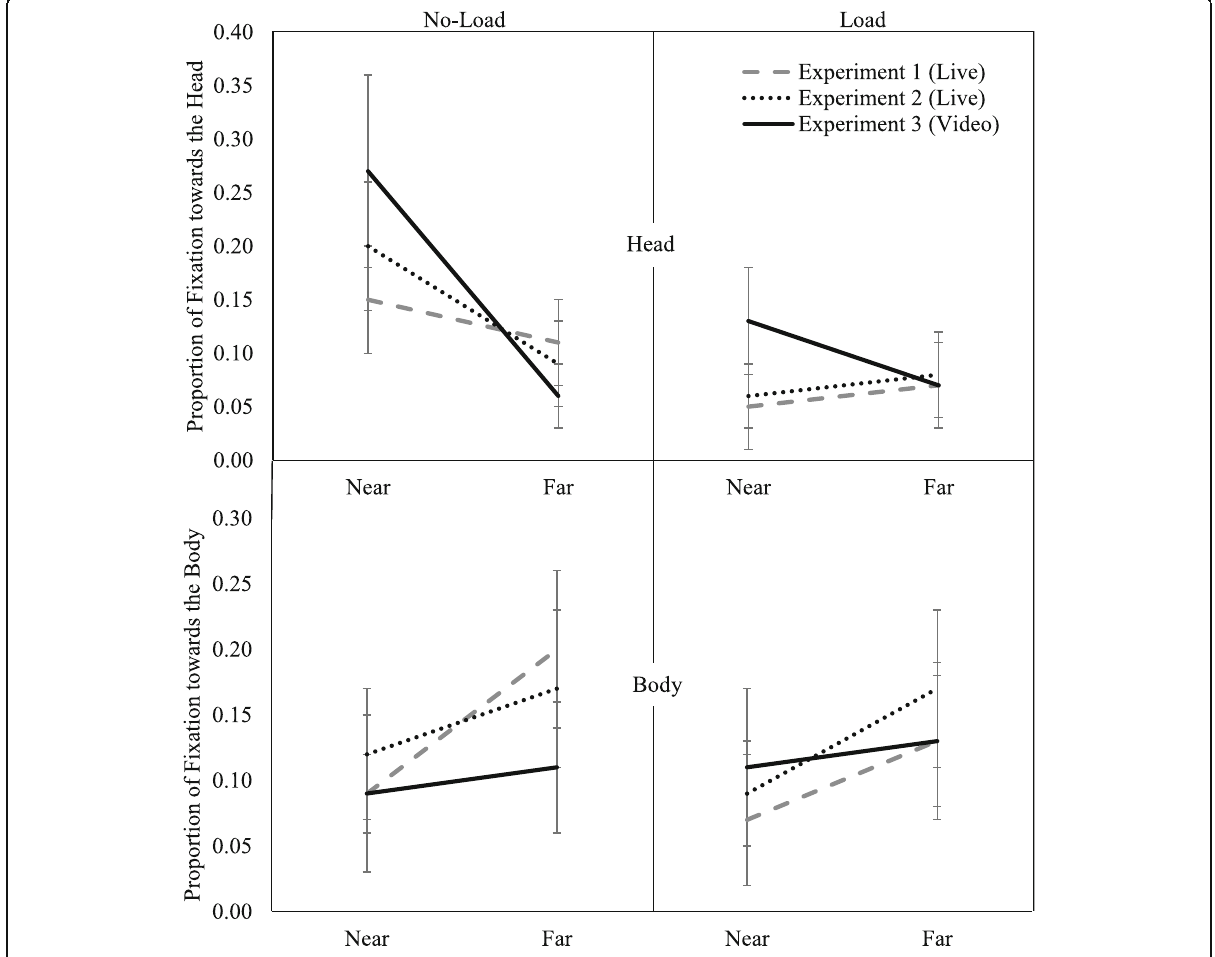
Fig. 6 The mean proportion of fixations as a function load, location and Experiment. Bars represent 95% confidence